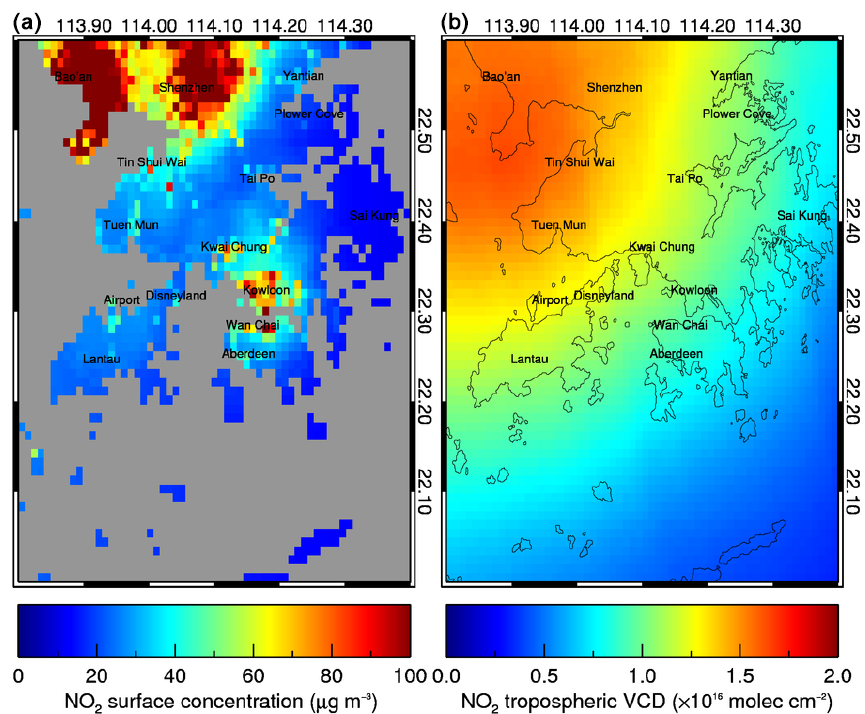
Figure 2. Comparison of the mean surface NO 2 concentration estimated by Model 1 (left) and the mean tropospheric VCD measured by OMI (right) during the period 2005–2015. Grey regions indicate regions beyond the scope of the model – oceans and areas where no cloud-free satellite measurements were available during this period. Important areas are